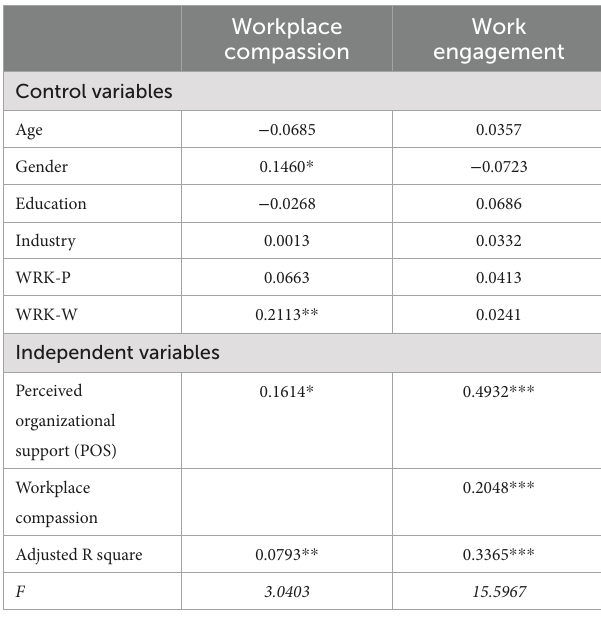
TABLE 8 Results of the regression analysis for nomological network ( N = 255).